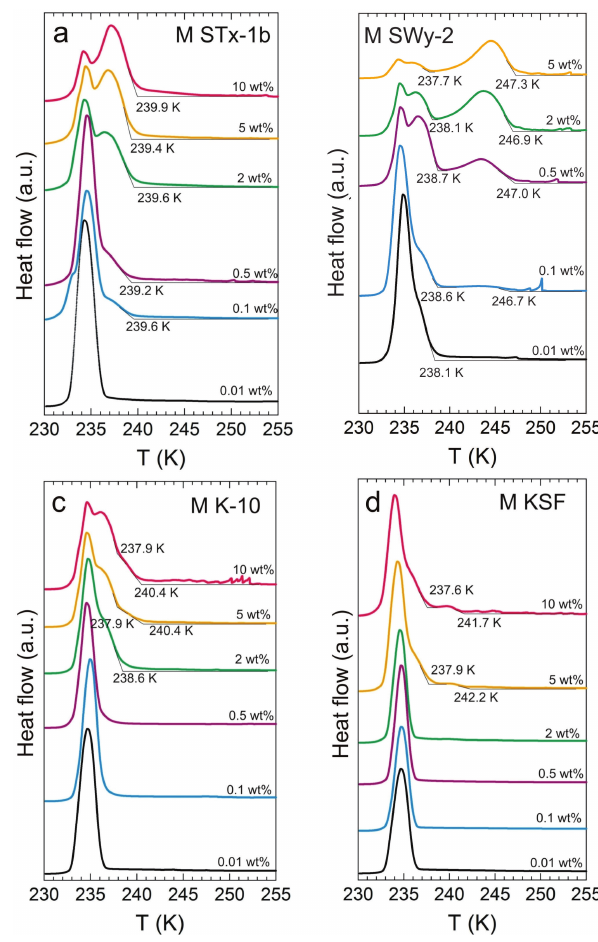
Fig. 5. DSC thermograms of M STx-1b (panel a ), M SWy-2 (panel b ), M K-10 (panel c ) and M KSF (panel d ). Curves are shown with different offsets for clarity. Suspension concentrations and on- sets of heterogeneous freezing are indicated above and below the curves, respectively. The onset of the freezing peaks ( T on ) is given by the intersection of the two tangent lines (thin black curves) for each